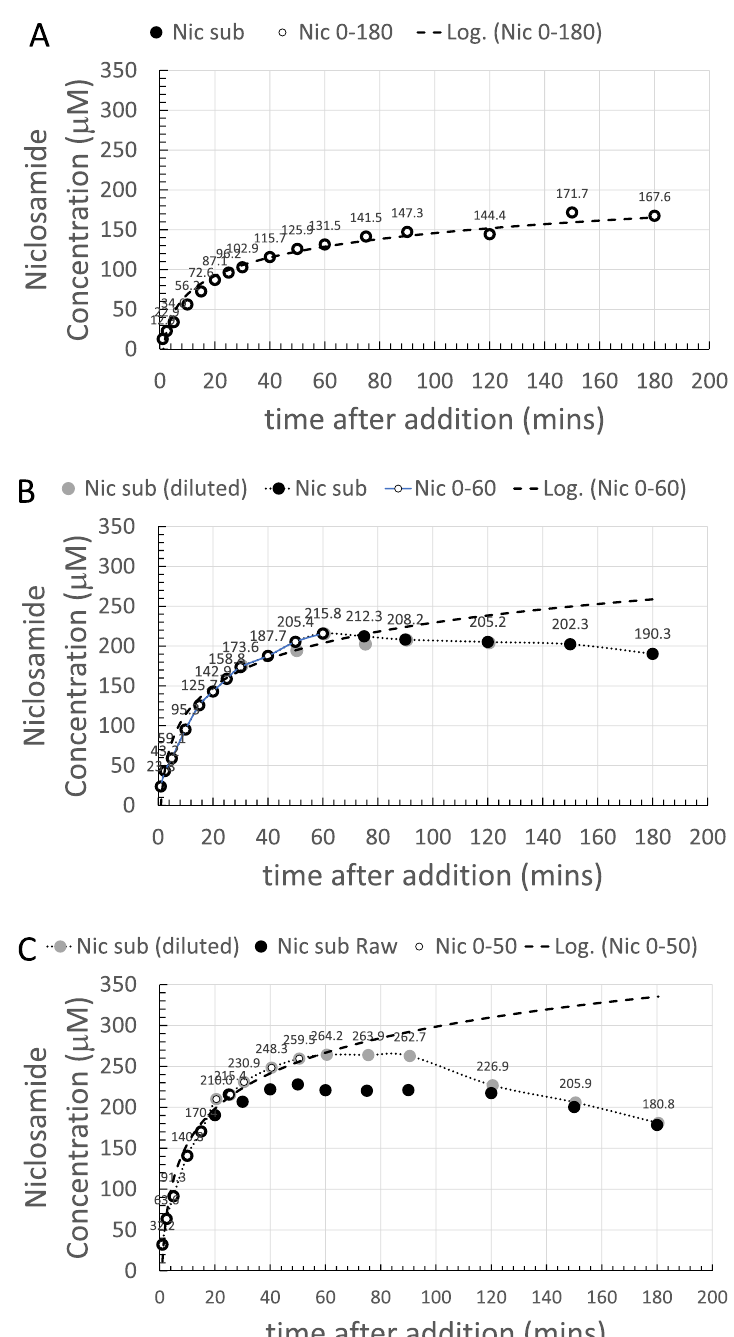
Fig. 4 Dissolution of Yomesan-niclosamide equivalent in nominal pH 9.35 Tris buffers (0–180 min): A 300 µM, B 600 µM, and C 1 mM. White symbols signify the data points used for the logarithmic fit (dashed line) up to each peak time point of 180 min, 60 min, and 60 min respectively. Gray-filled symbols ( B and C ) represent a 2 dilution as the niclosamide concentration increased and approached the limit of detection for the × UV-Vis absorbance detector. Error bars were ~ 1.5 µM and so within the filled symbols. The dotted line is to guide the eye and show the deviation from